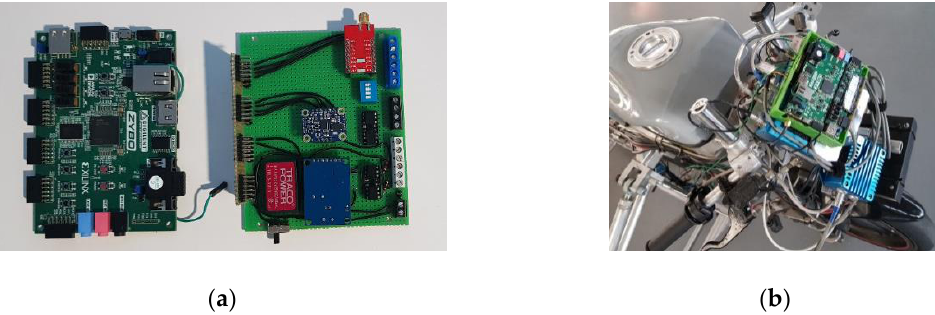
Figure A1. ( a ) Electronic control unit and ( b ) implementation in a two-wheeled vehicle.